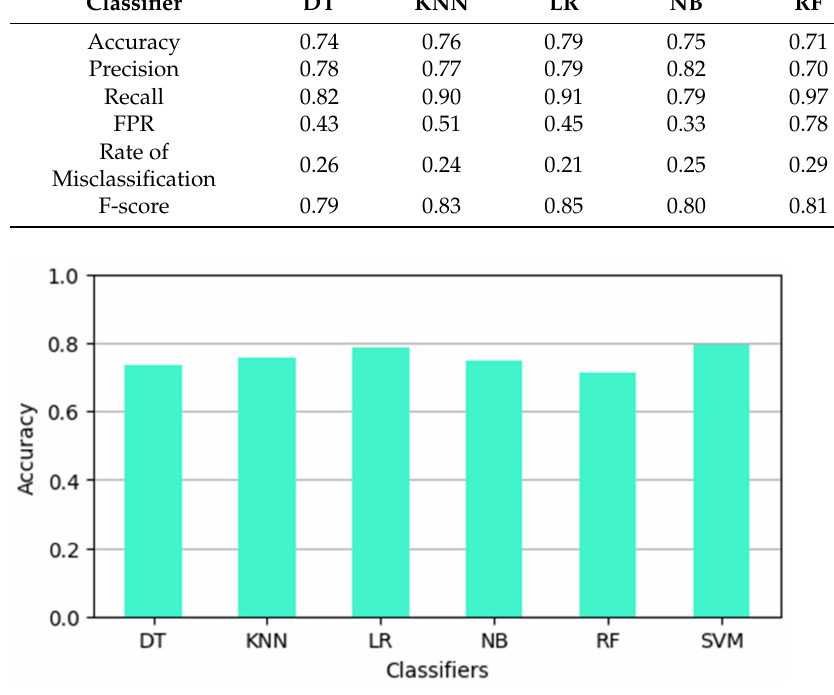
Figure 1. Accuracy of ML classifiers on COVID-19 Fake News